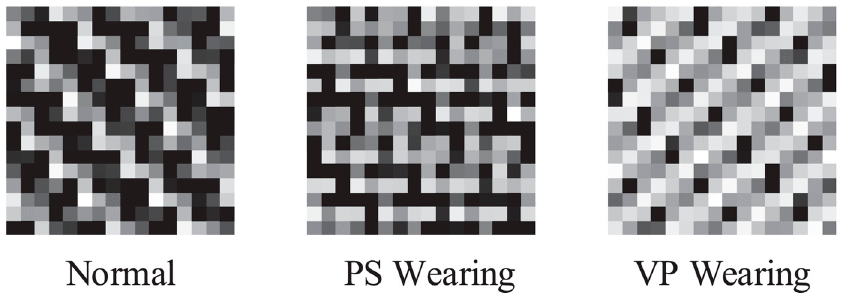
Figure 4. Converted images on nine fault conditions from [98] , Copyright 2018, IEEE.